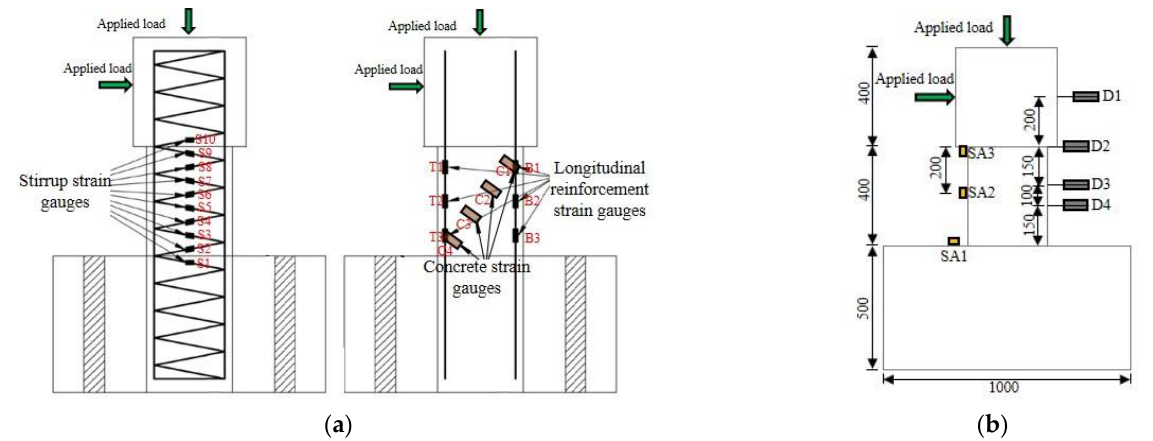
Figure 7. Arrangement of the transducers. ( a ) Strain gauges; ( b ) Smart aggregate and displacement transducers.